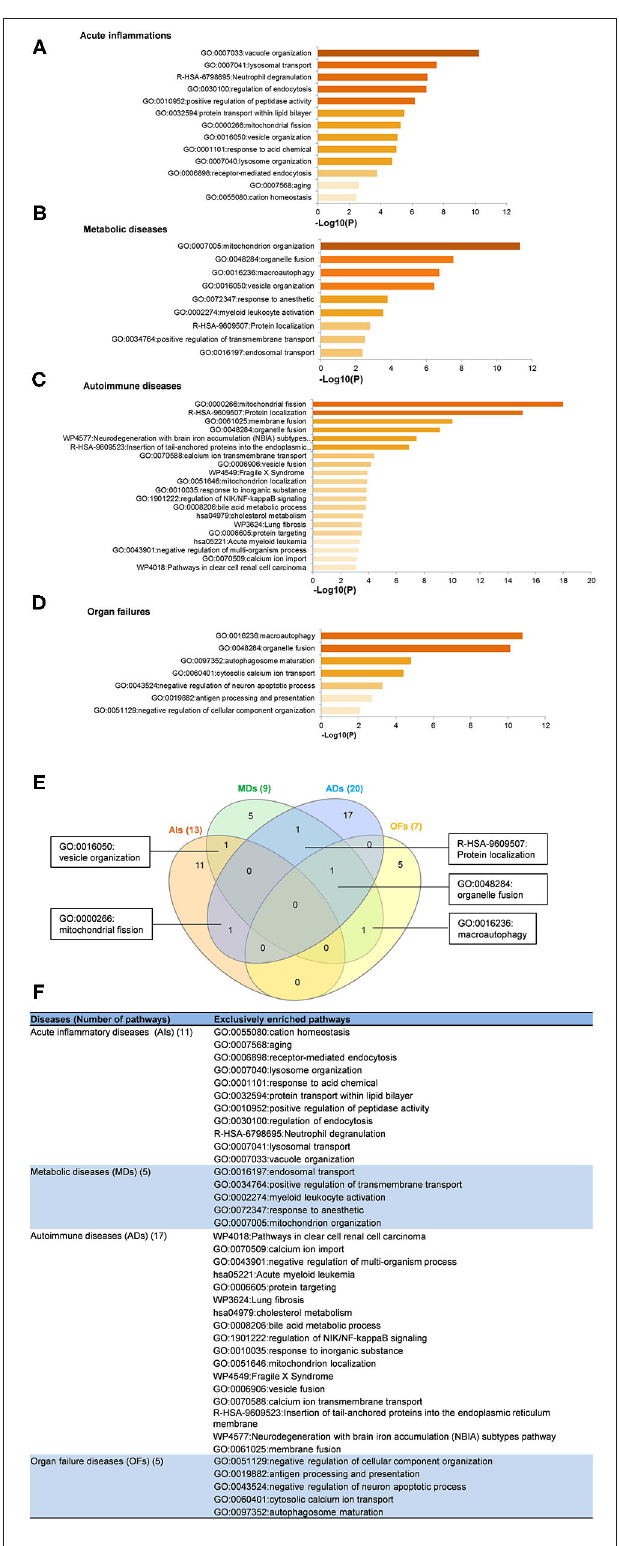
FIGURE 4 | Enrichment analysis results show that several pathways of upregulated OCRGs were involved in acute inflammations (AIs), metabolic diseases (MDs), autoimmune diseases (ADs), and organ failures (OFs). Gene